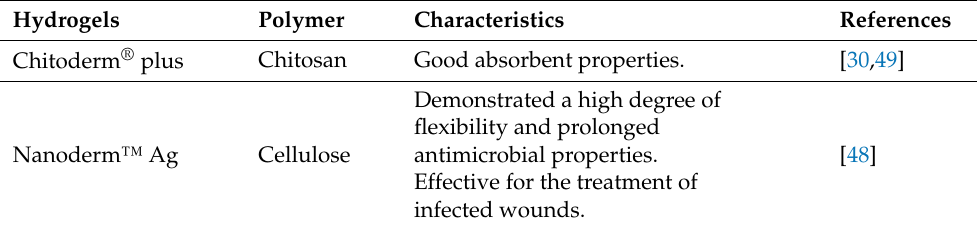
Demonstrated a high degree of flexibility and prolonged antimicrobial properties. Effective for the treatment of infected